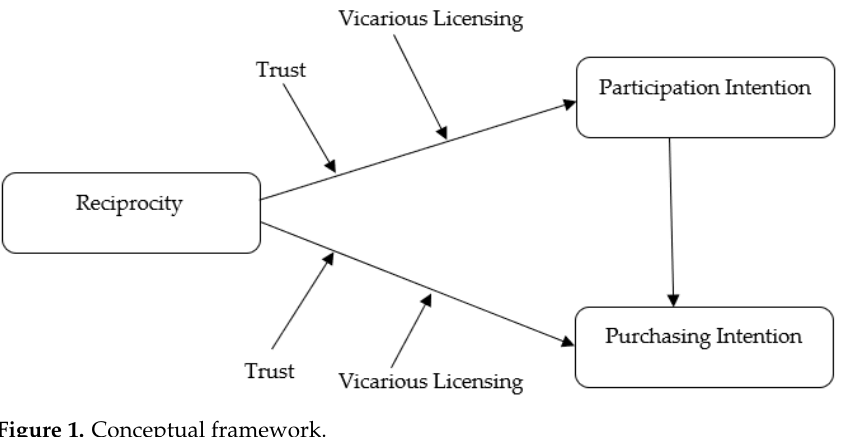
Figure 1. Conceptual framework.